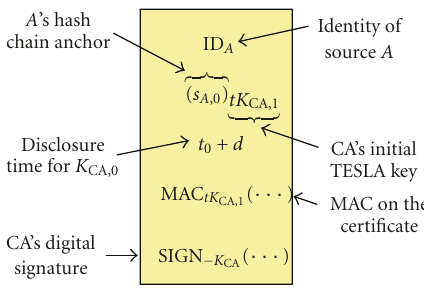
Figure 2: TESLA certificate for node A